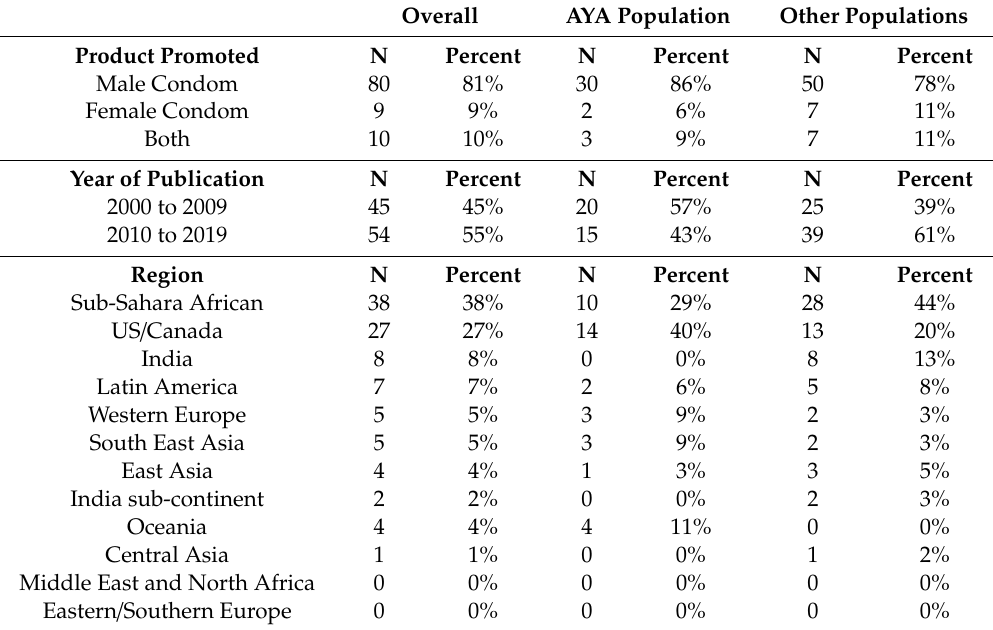
Figure 2. Preferred Reporting Items for Systematic Reviews and Meta-Analyses (PRISMA) diagram of systematic review process. Table 1. Characteristics of the publications